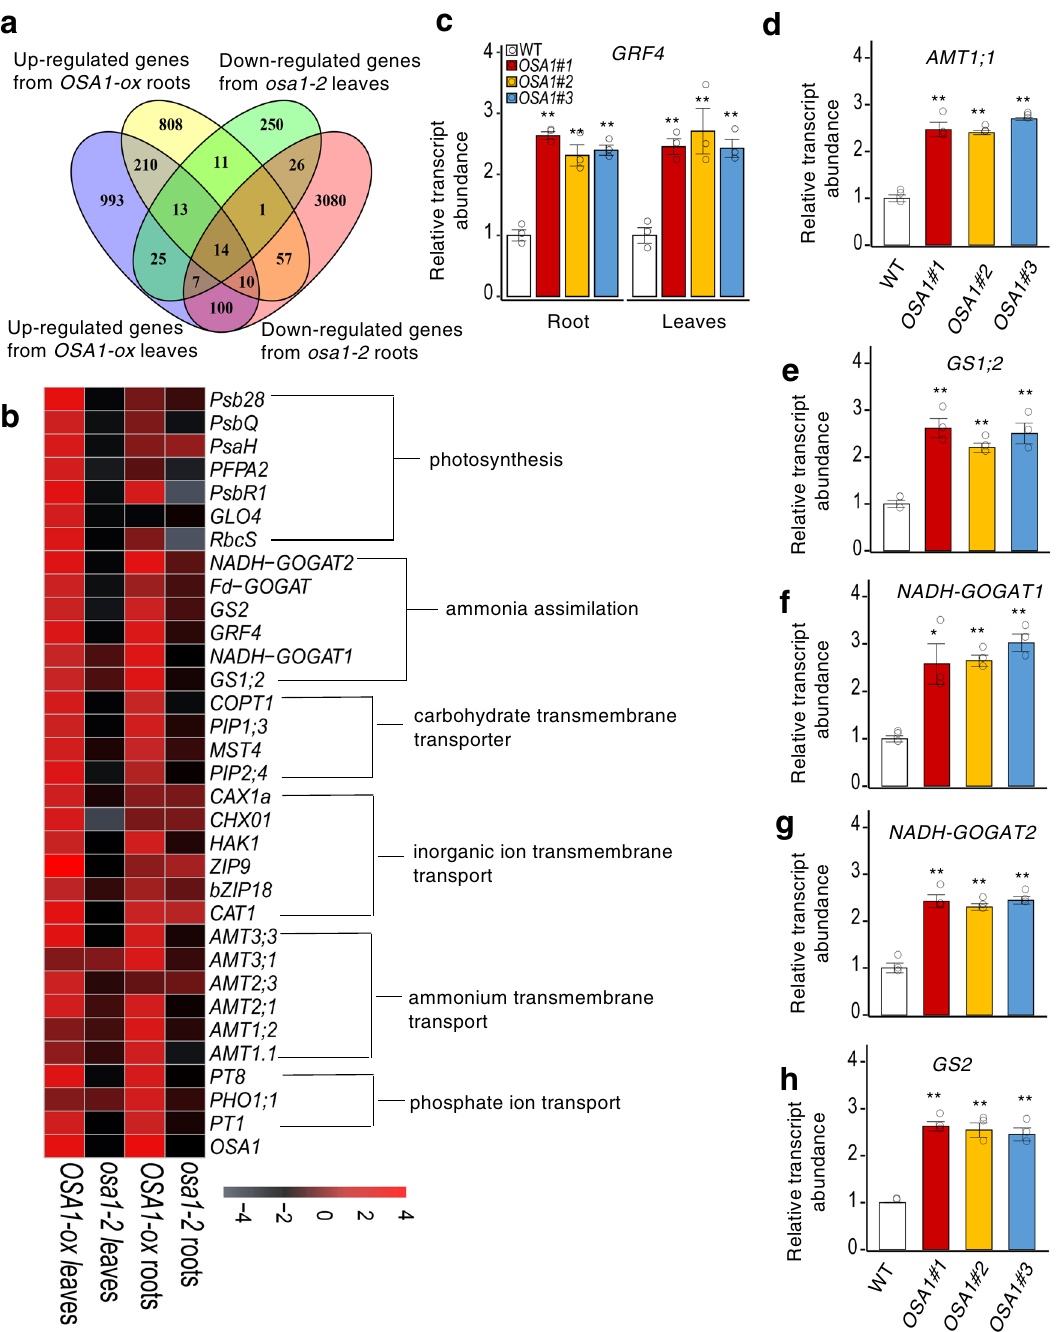
Fig. 5 Differentially expressed genes (DEGs) enrichment caused by the modi fi cation of OSA1 in rice. a Venn diagram representing overlapping upregulated genes in OSA1 -ox and downregulated genes in the osa1-2 mutant ( osa1 ) in roots and leaves (false discovery rate [FDR] < 0.05). b Heat map of the DEGs. Signi fi cant genes in response to N, C metabolism and ion transport are listed (FDR < 0.05). c – h Relative expression of N metabolism-related genes in WT and OSA1 -ox roots ( c – f ) and leaves ( c , g , h ). Plants were grown hydroponically in a greenhouse for 4 weeks. Small circles in c – h represent data points for individual experiments; three biological replicates were analysed for each treatment. Columns and error bars in c – h represent the means ± SEs ( n = 3). Differences were evaluated using the two-tailed Student ’ s t test (* P < 0.05; ** P < 0.01). The exact P values are provided in the Source Data fi ef fi ciently take up NH 4 + in the fi eld soils with frequently fl uc- tuated NH 4 + concentration. Our results also indicate that OSA1 overexpression may enhance NH 4 + assimilation capacity. Genes